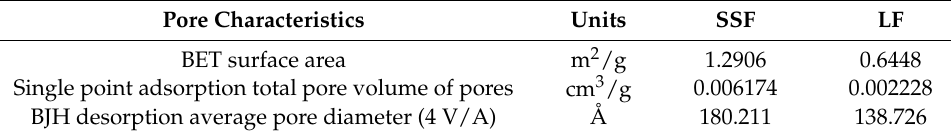
Figure 3. Surface characterization of fillers: SSF ( A 1 , A 2 ) and LF ( B 1 , B 2 ). Table 3. Pore characteristics of SSF and